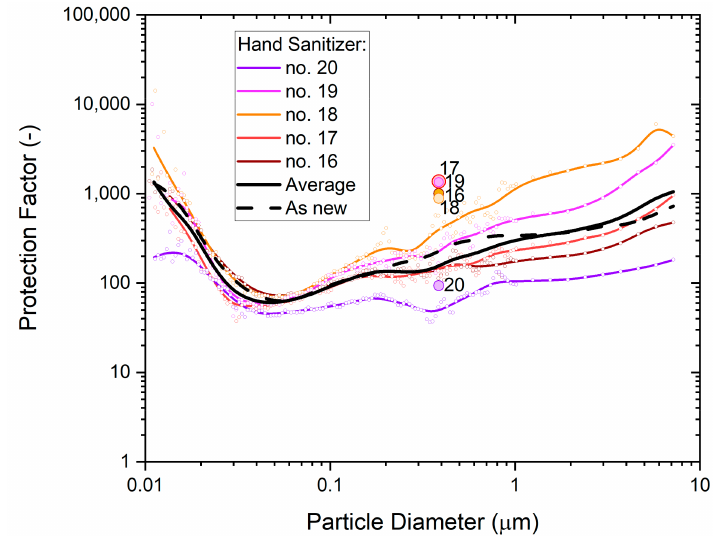
Figure 10. The particle size dependence of the protection factor of five P2-SD disposable respirator masks (Shanghai Da Sheng, box 2) after exposure to hand sanitizer vapors; colored dots represent particle size-specific measurements (SMPS, OPS) of the respective mask, with b-spline curves provid- ing visual context; results from non-destructive testing are shown as circular dots with corresponding coloring at 0.39 µ m particle size. The geometric average of the five masks is represented by the black solid line, and the performance of a single unused mask (as new) is shown for comparison by the black dashed line.